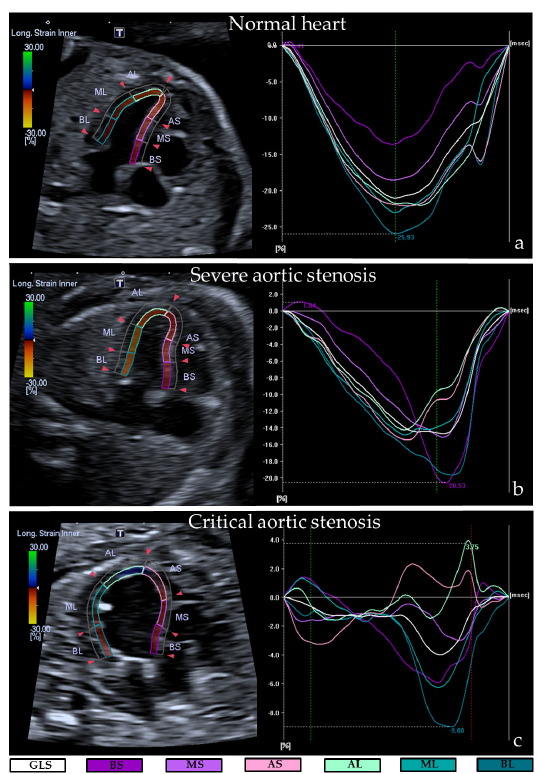
Figure 2. Decreased left ventricular myocardial deformation in cases with fetal aortic stenosis. Representative examples of global longitudinal strain and segmental longitudinal strain analysis for normal hearts ( a ), severe aortic stenosis ( b ) and critical aortic stenosis ( c ), showing the myocardial trace ( left ) and strain curves ( right ). Note that myocardial deformation is most overt in the critical aortic stenosis case. GLS, global longitudinal strain; BS, basal septal; MS, mid septal; AS, apical septal; AL, apical lateral; ML, mid lateral; BL, basal